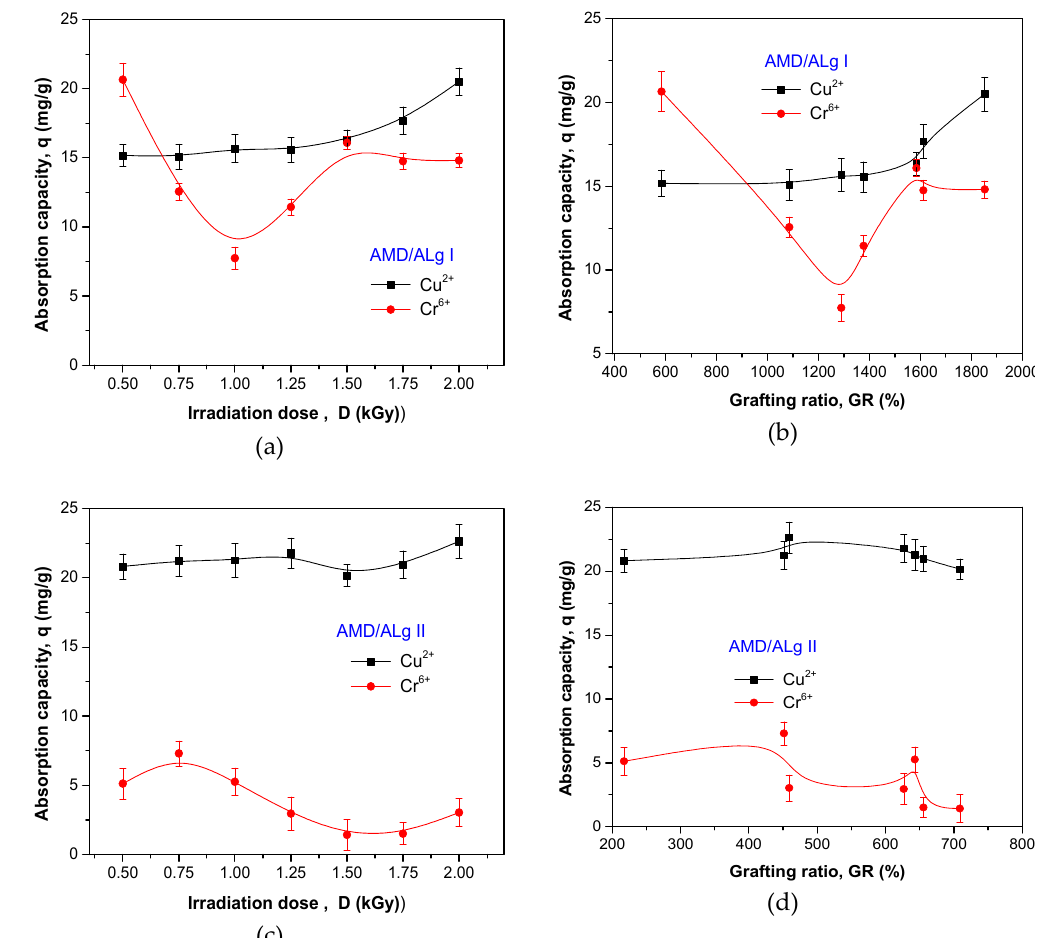
Figure 12. The influence of irradiation dose, grafting ratio, and sodium alginate concentration on equilibrium absorption capacity. ( a ) absorption capacity versus irradiation dose for AMD/ALg I samples; ( b ) absorption capacity versus grafting ratio for AMD/ALg I samples; ( c ) absorption capacity versus irradiation dose for AMD/ALg II samples; ( d ) absorption capacity versus grafting ratio for AMD/ALg II samples.